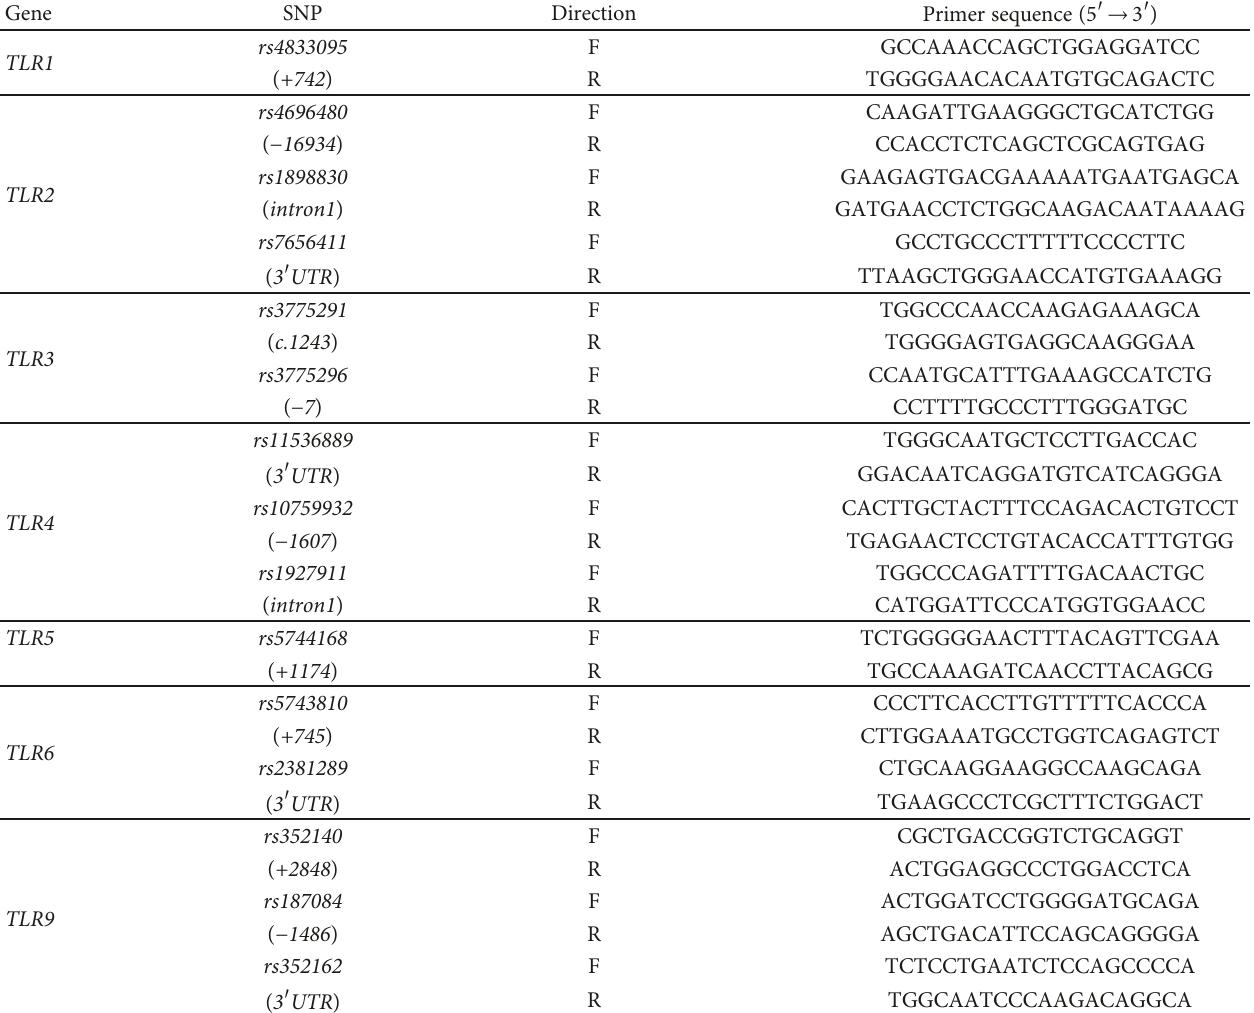
Table 2: Primer sequences for each single-nucleotide polymorphism.